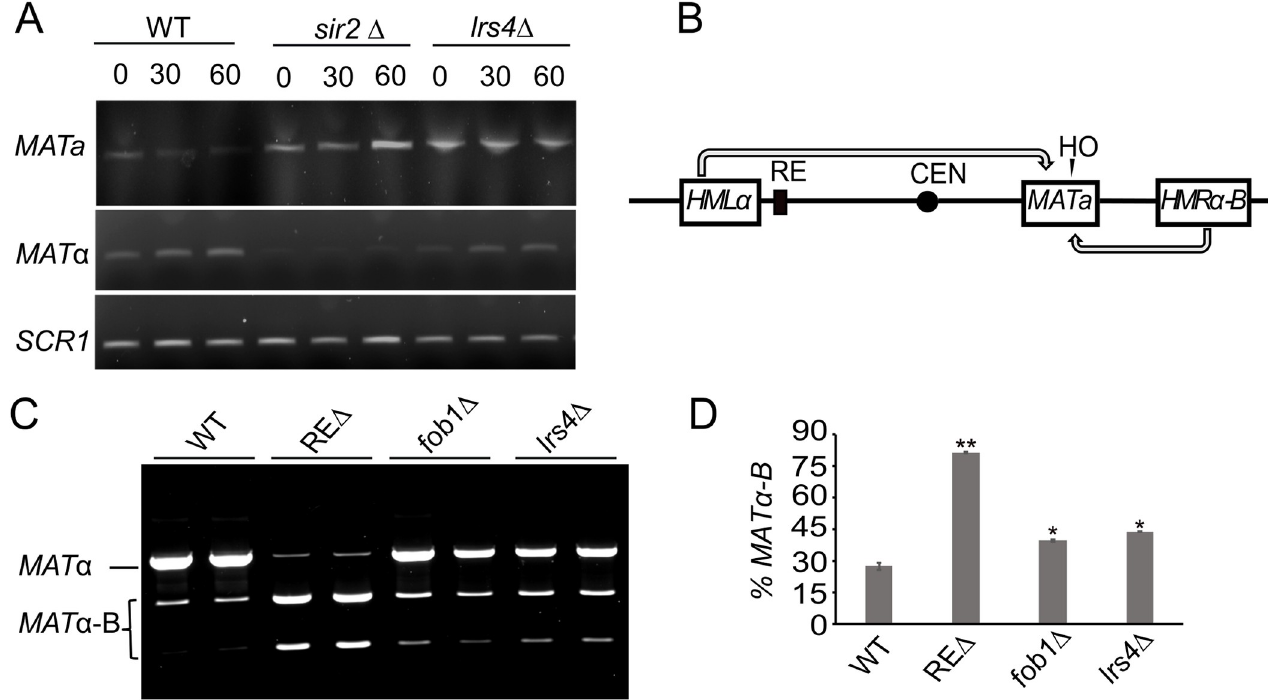
Fig 5. Contributions of Lrs4 and Fob1 to mating-type switching. ( A ) Time-course of mating-type switching in WT (ML447), sir2 Δ (ML458) and lrs4 Δ (MD69) showing PCR detection of MAT a and MAT α . SCR1 is used as a control for input genomic DNA. ( B ) Schematic of the donor preference assay that distinguishes usage of HML α or an engineered HMR α -B cassette as the donor template by digestion of a MAT α PCR product with Bam HI. ( C ) Donor preference assay with WT (XW652), lrs4 Δ (SY762), fob1 Δ (MD135), or RE Δ (XW676) showing Bam HI digestion of the MAT α PCR product after switching. Upper band indicates normal donor preference switching to MAT α using HML α as the template. Digested bands indicate improper switching to MAT α -B using HMR α -B as the template. ( D ) The percentage of MAT α -B PCR product is quantified in the bar graph. Significant increases compared to WT = * p < 0.05, ** p < 0.005 (n = 3), as calculated by 2-tailed student t-test.